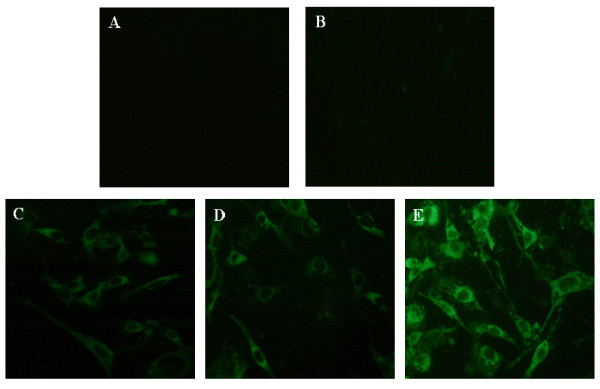
The intracellular location of ORFV011 protein, ORFV059 protein and ORFV 011/ORFV059 chemeric-proteins in transfected OFTu cells. The OFTu cells were seeded in 6-well culture plates and un-transfected (Figure 2a) or transfected with pcDNA3.1(+) vector (Figure 2b), pcDNA3.1-ORFV011 plasmid (Figure 2c), pcDNA3.1-ORFV059 plasmid (Figure 2d) or pcDNA3.1-ORFV011/ORFV059 plasmid (Figure 2e) for 48 h. After 48 h post-transfection, the cells were fixed with 80% acetone for 10 min at -20°C, rehydrated in PBS, labeled with a rabbit anti-ORFV polyclonal antibody, and washed three times with PBS. FITC-conjugated goat anti-rabbit IgG (H + L) (1:500 dilution in PBS) was added to the OFTu cell mixtures for 30 min at room temperature, and the cells were washed and observed with a fluorescence microscopy. Magnification: 400 ×.